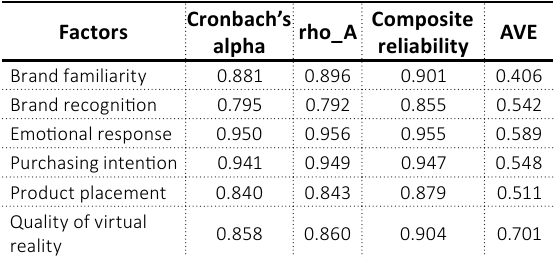
Table 1. Descriptive, Cronbach’s alpha, CR, rho_A